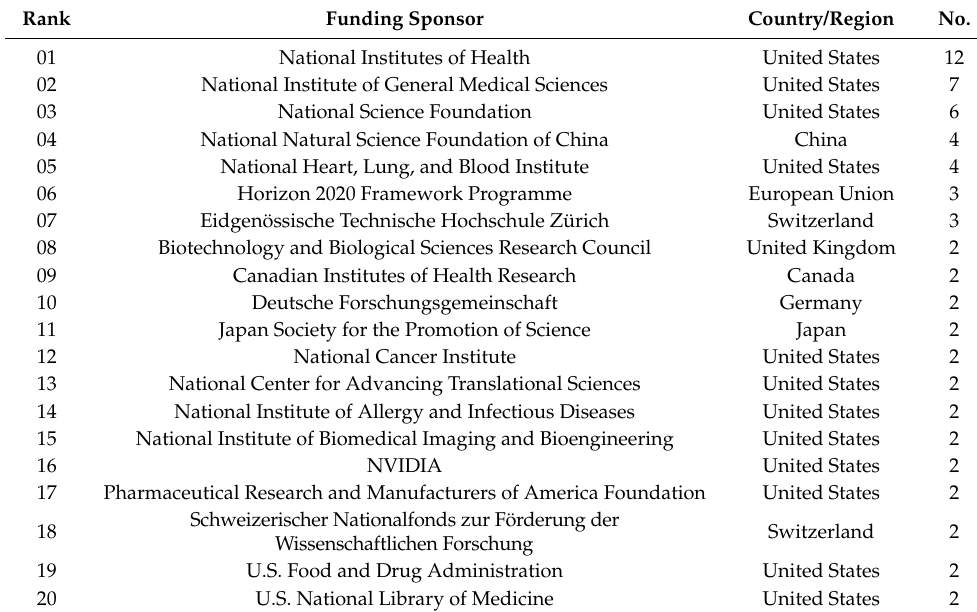
Table 6. Overview of the funding sponsors of the 100 most cited articles.